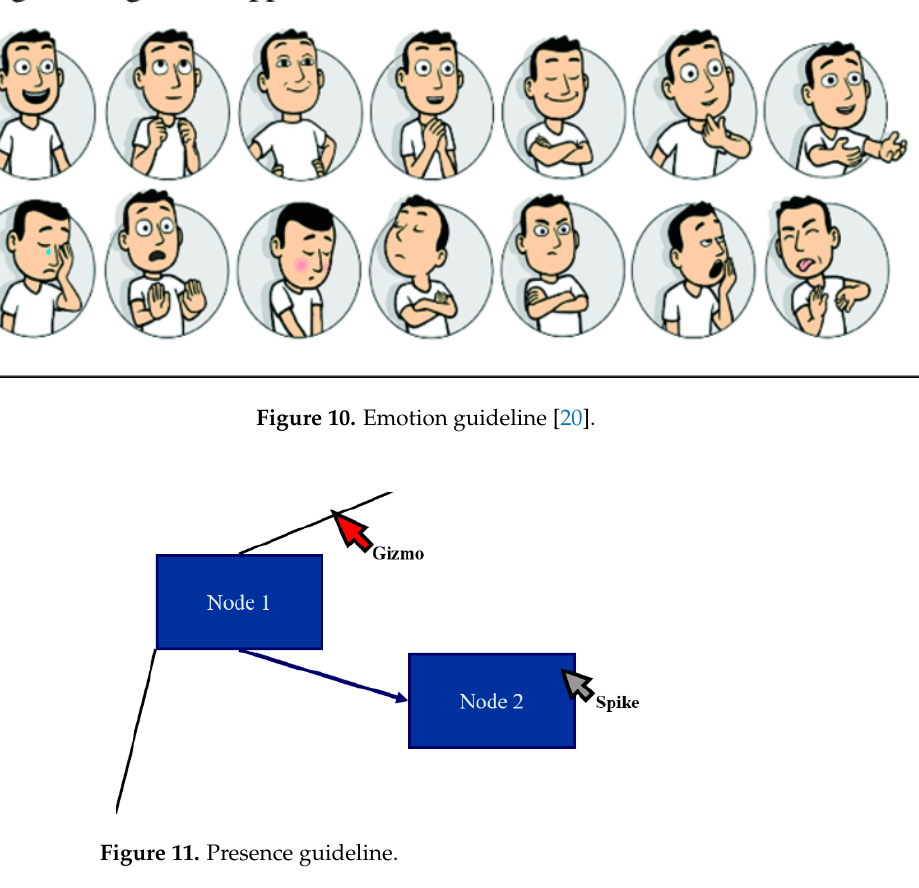
Figure 11. Presence guideline.